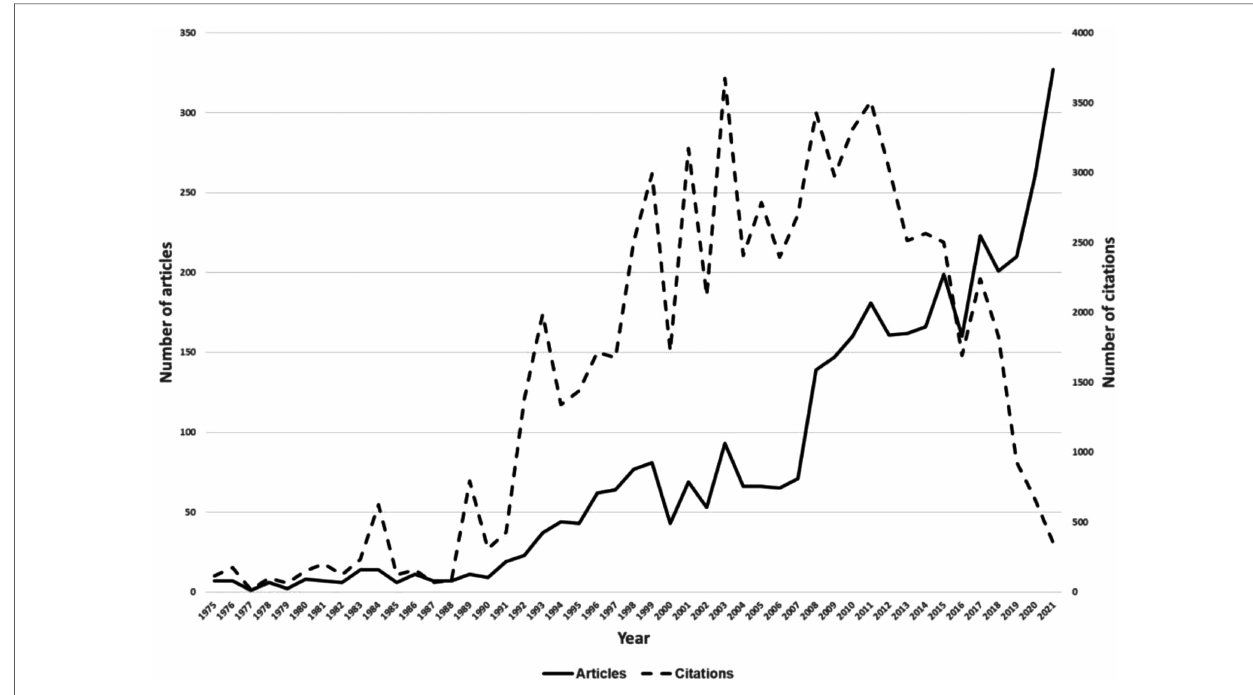
FIGURE 1 Trend of citations and articles published in web of science until 2021. The trend is represented by a polynomial trend line of degree